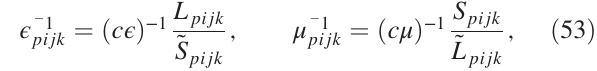
FIG. 5. Curved metal boundary in a Cartesian material parameters, and the lengths and areas of the grid edges and faces, respectively. In the standard staircase approximation the material matrices contain elements (without double indices for simplicity of notation)